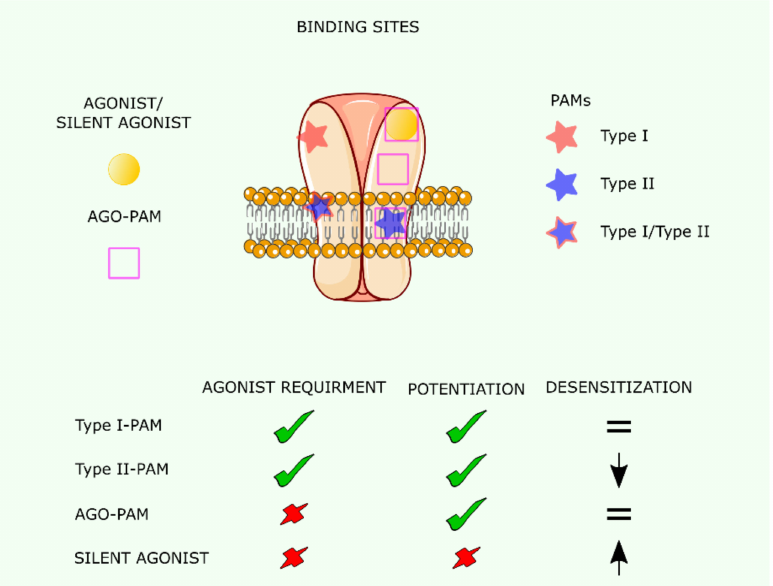
Figure 5. Pharmacology of α 7 nAChR positive allosteric modulators (PAMs), agonist-PAMs, and silent agonists. The orthosteric binding sites are located at the interface of two subunits and are used by agonists, ago-PAM, and silent agonists. Allosteric sites were described in the transmembrane domain 2 (TM2) between the extracellular domain (ECD) and the TMD, at the ECD and in the interface between subunits in the ECD. PAMs and ago-PAMs use these sites to potentiate activation through the orthosteric site. The bottom part of the figure shows the effect of the different types of ligands on α 7 nAChR-mediated